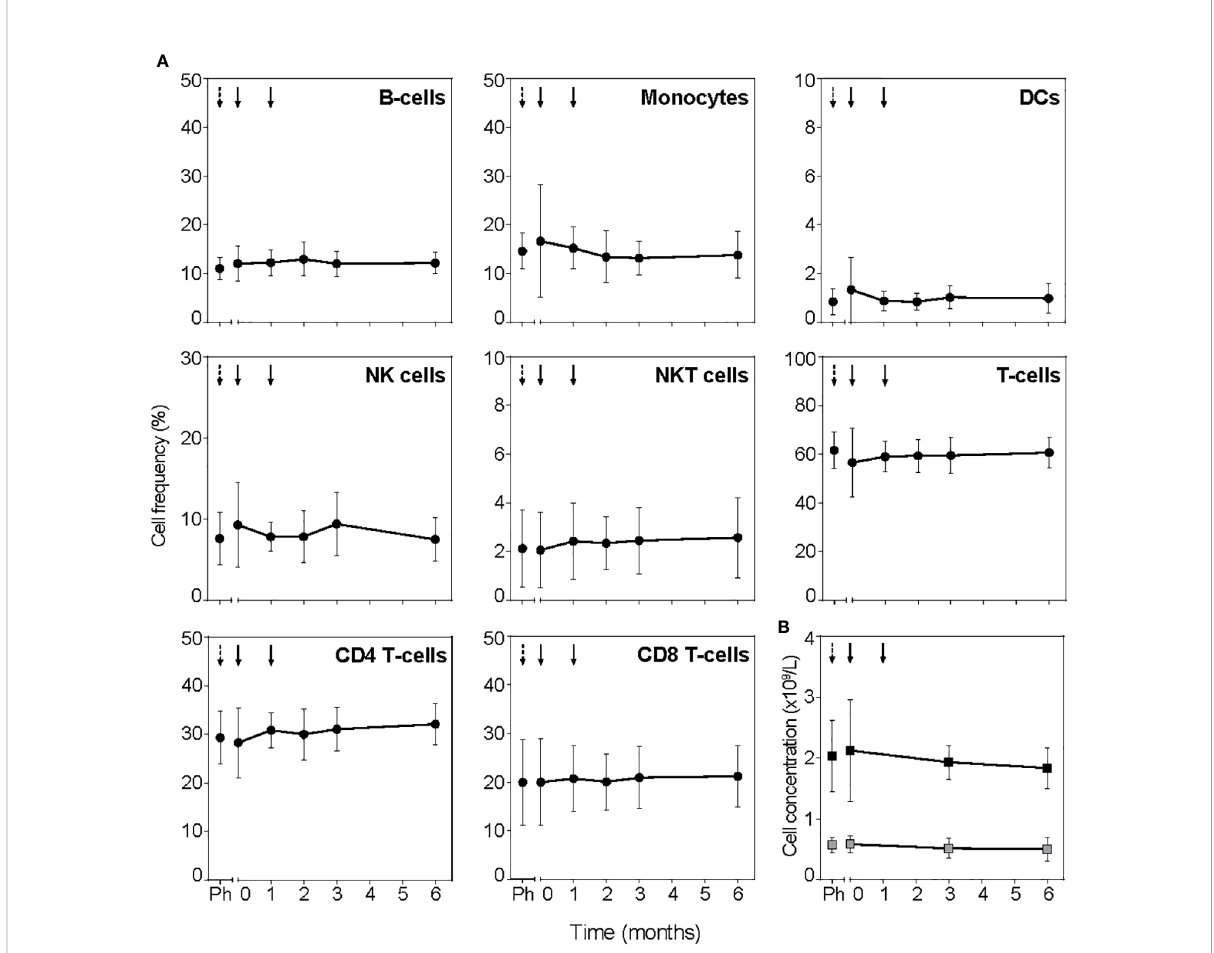
FIGURE 4 TolDC treatment does not change PBMC subsets. (A) Frequency of leukocyte subsets determined in full blood by fl ow cytometry. Timepoint before leukapheresis is indicated with black dashed arrow (Ph) and tolDC treatment with black arrows. (B) Lymphocytes (black squares) and monocytes (grey squares) determined in absolute cell counts. Symbols represent the mean value ± SD of all patients. TolDC treatments are indicated with black arrows, dashed arrow (Ph) indicates timepoint before